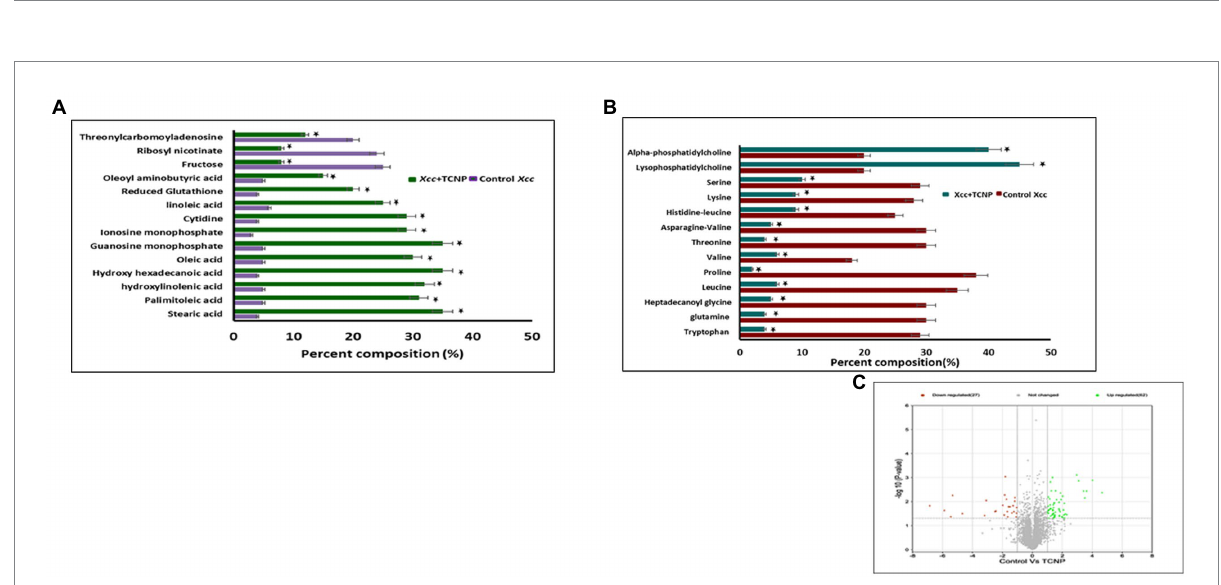
FIGURE 6 (A) Bar graph of top 27 differential metaboloites in the control and TCNP treated Xcc cells for fatty acids, nucleic acids, sugars etc. (B) Bar graph of metabolic response the control and TCNP treated Xcc cells for amino acids and lipids etc. Data bars indicate increased/decreased percentage of metabolite levels in treated Xcc cells. (C) Volcano plot showing upregulation and down regulation of metabolites. Values are means of 5 biological replicates. Data bars represent increased/decreased percentage percentage of metabolite levels in treated Xcc cells and considered statistically significant when * p <